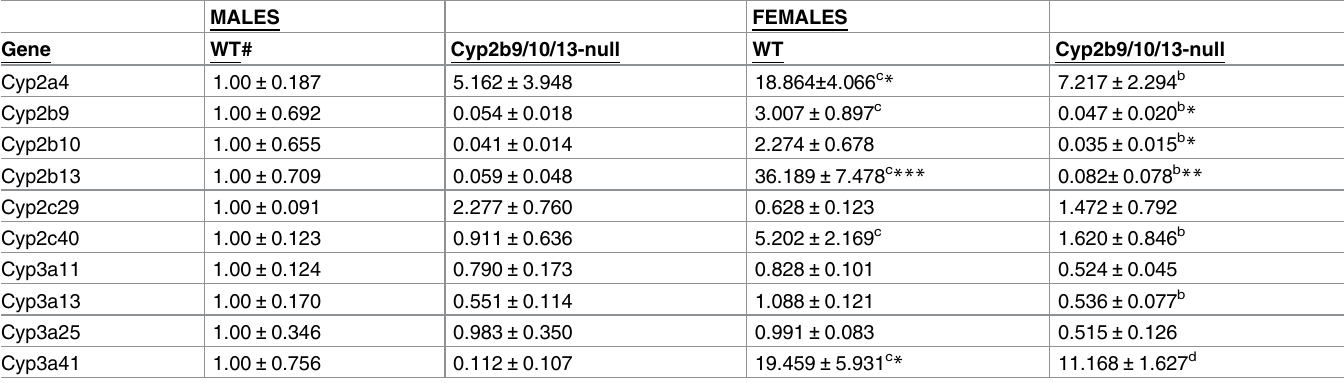
Table 3. Compensatory changes in CYP gene expression in Cyp2b9/10/13-null